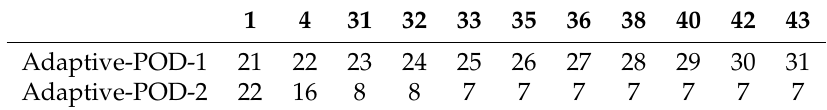
Table 3. Number of POD basis for saturation after each update of POD subspace for Equation (19).